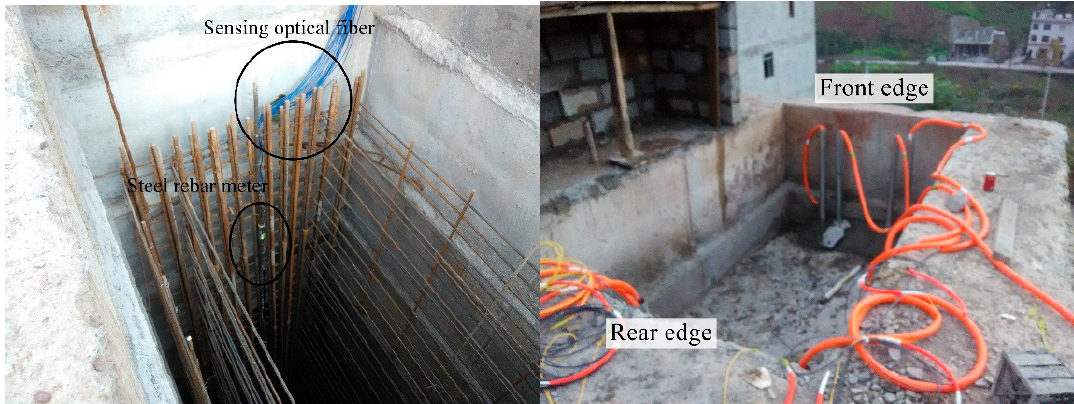
Figure 4. Site construction picture of the anti-slide pile.